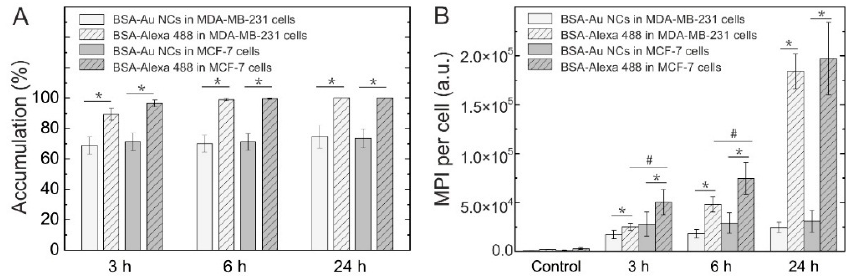
Figure 3. Accumulation of photoluminescent BSA-Au NCs and BSA-Alexa conjugate in MCF-7 and MDA-MB-231 cells after 3, 6, and 24 h of incubation. Percentage of the cells that have accumulated BSA-Au NCs and BSA-Alexa conjugate ( A ); mean PL intensity (MPI) of BSA-Au NCs and BSA-Alexa conjugate per cell ( B ). Control represents autofluorescence of non-treated cells. Error bars show the standard deviations. * indicates significant differences between accumulation of BSA-Alexa 488 and BSA-Au NCs ( p ≤ 0.05); # indicates significant differences between the MCF-7 and MDA-MB-231 cell lines ( p ≤ 0.05).